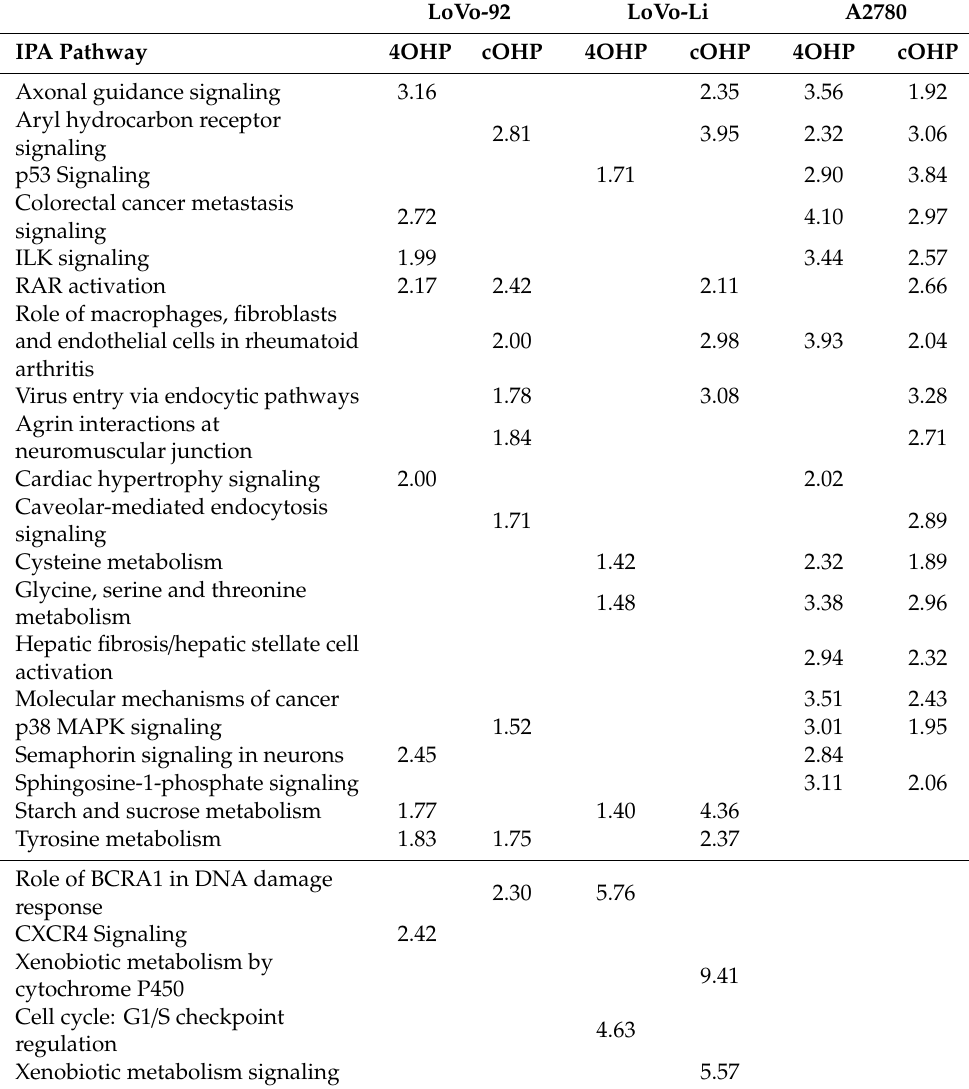
Table 3. Significance of most frequently observed enriched canonical